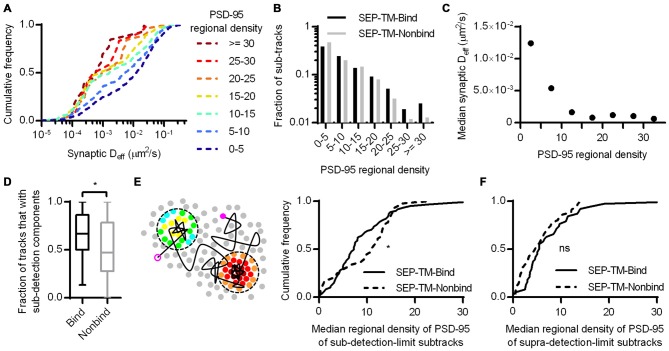
Subsynaptic regional density of PSD-95 influences the mobility of a probe that does not bind PSD-95. (A) Cumulative frequency distributions of the nonbinding probe Deff binned in increasing regional densites of PSD-95 surrounding the subtracks (n = 480 subtracks in 0–5 PSD-95, 204 in 5–10, 148 in 10–15, 81 in 15–20, 32 in 20–25, 12 in 25–30, 13 in 30+). (B) Fraction of subtracks in different regional densities of PSD-95. (C) PSD-95 regional density and the median Deff of the nonbinding probe. (D) Fraction of tracks with subsegments that were slowed below the detection limit per PSD (n = 113 PSDs for SEP-TM-Bind, 91 SEP-TM-Nonbind; *p = 0.0123 Mann-Whitney U test). (E) (Left) Cartoon highlighting the PSD-95 molecules surrounding subtrack durations that diffused below the detection limit. The open and closed purple circles indicate the beginning and end of a track, the circles pseudo-colored by regional density were within 30 nm of sub-detection limit subtracks. We calculated the median regional density of PSD-95 of all subtrack durations that diffused below the detection limit with every PSD. (Right) Median regional density of PSD-95 surrounding subtracks that were below the detection limit (n same as in D; *p = 0.0325 K-S test). (F) Median regional density of PSD-95 surrounding subtracks that above the detection limit (n same as in D; ns, Not significant, p = 0.158 K-S test).